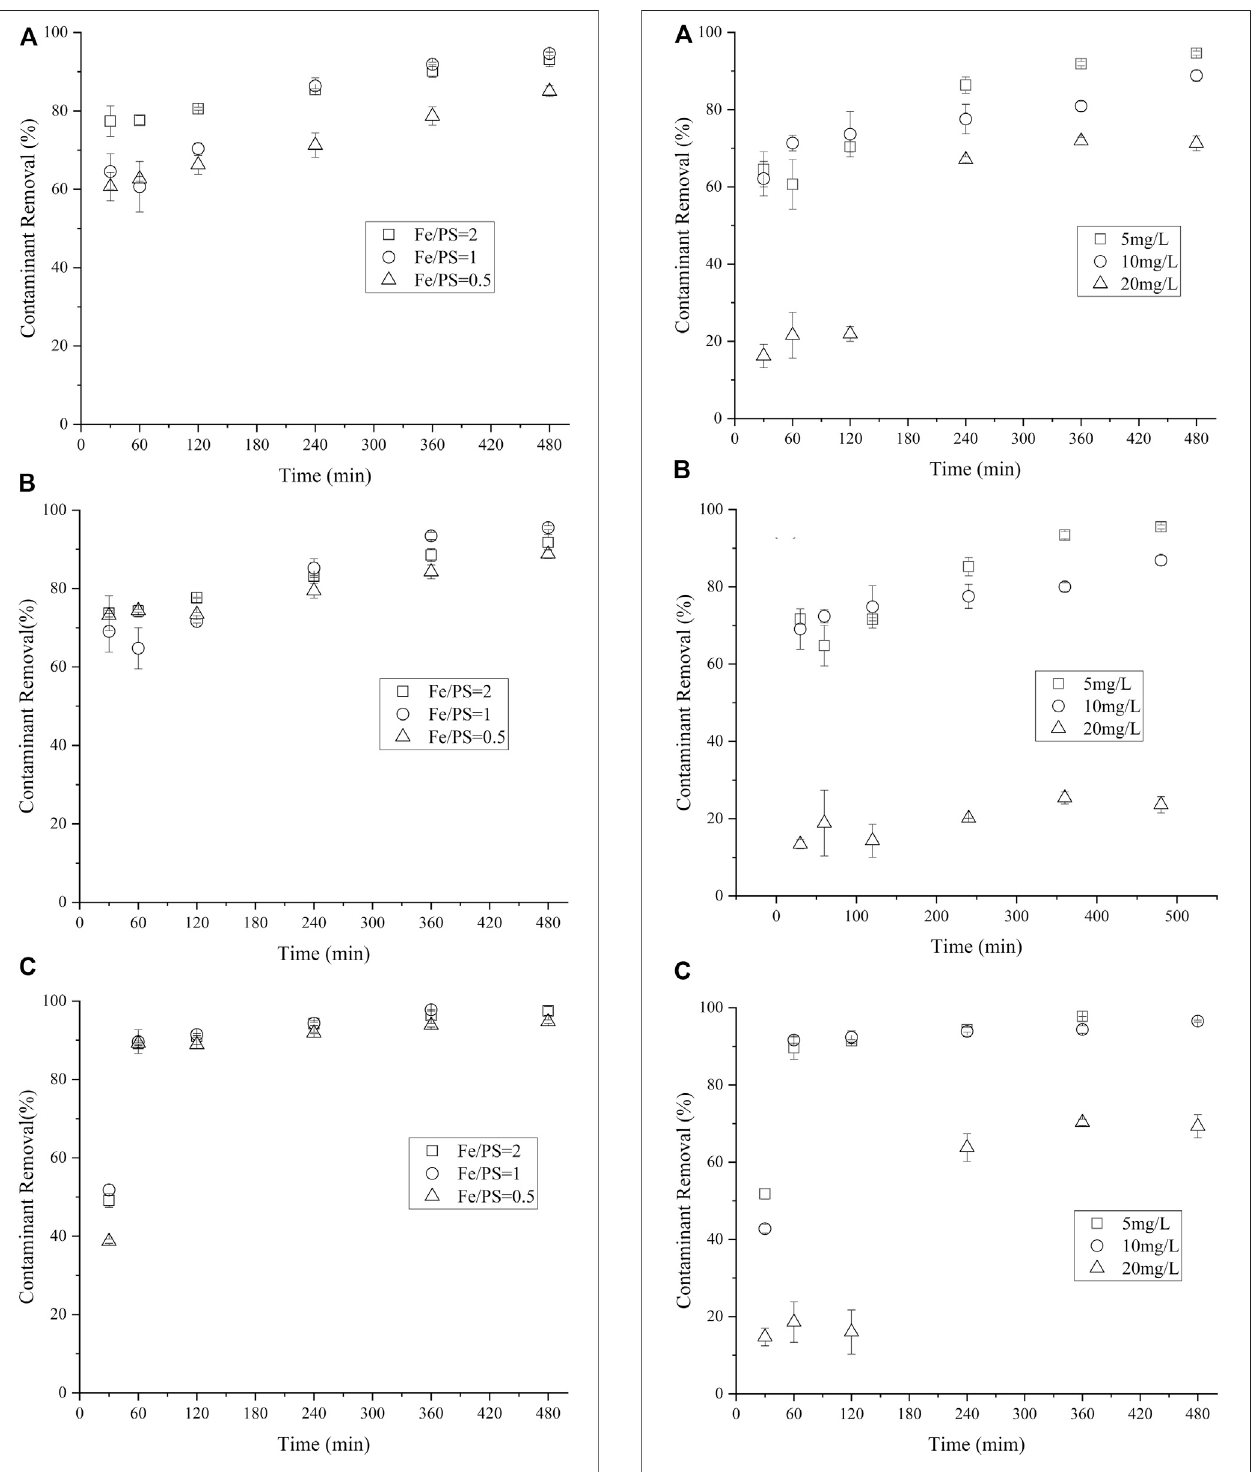
FIGURE 6 | Effect of mole ratio of Fe/PS on m-NCB (A) , P-NCB (B) and o-NCB (C) degradation. The nZVI/BC amount 0.02 g, the initial NCB isomer concentration 10 mg L − 1 .